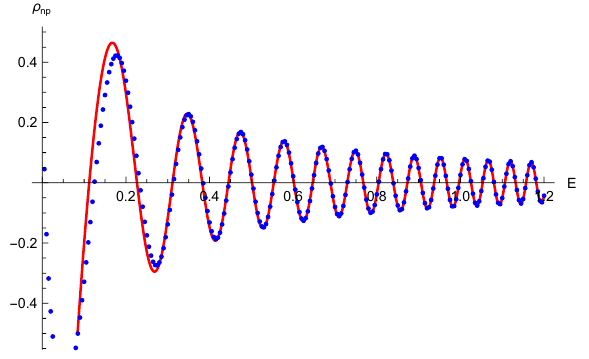
Figure 2 . Plot of (cid:26) np ( E ) for ~ = 1 = 30. Blue dots represent the numerical value of (cid:26) np ( E ) obtained from (4.2) while the red curve is the plot of analytic expression in (4.9).